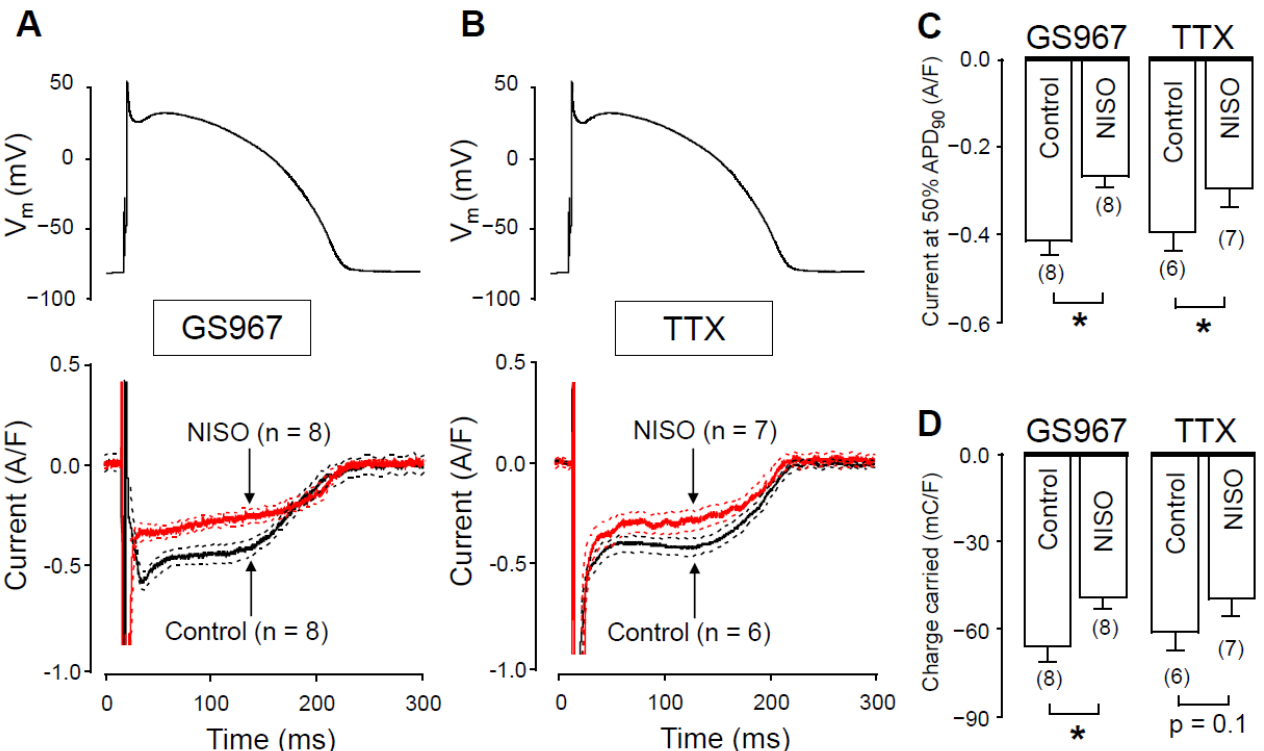
Figure 2. GS967-sensitive and TTX-sensitive currents were recorded under action potential voltage-clamp conditions in the absence and presence of nisoldipine. ( A , B ) The command AP (above), GS967-sensitive ( A ) and TTX-sensitive ( B ) current profiles (below) obtained in the presence (NISO) and absence (Control) of 1 µM nisoldipine. Dashed lines denote SEM values. ( C , D ) Average current densities, measured at 50% of APD 90 ( C ), and current integrals ( D ) obtained in the absence and presence of nisoldipine with GS967 and TTX. Columns and bars are mean ± SEM, numbers in parentheses indicate the number of myocytes studied, asterisks denote significant differences between the NISO and control groups.